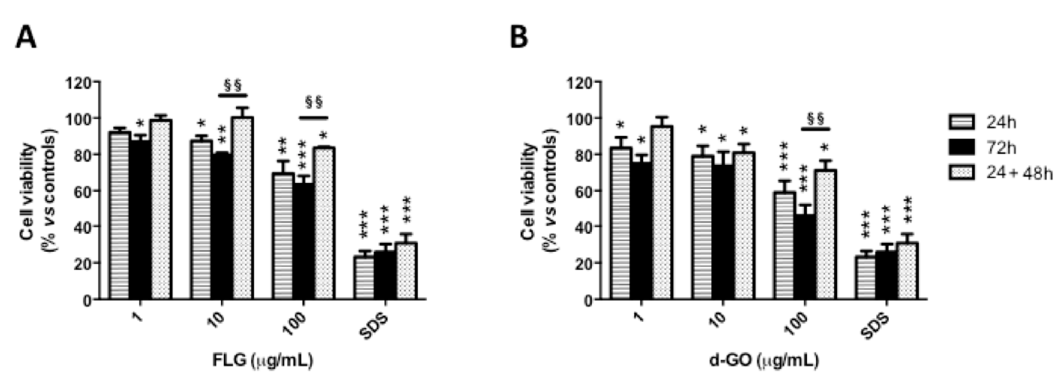
Figure 1. Cytotoxicity of graphene-based materials (GBMs) toward HaCaT cells. HaCaT cells were exposed to GBMs (1, 10 and 100 µ g / mL few layer graphene (FLG; ( A )) or graphene oxide (d-GO; ( B ))) for 24 or 72 h (continuous exposure), or for 24 h followed by 48 h recovery in GBM-free medium (recovery exposure; 24 + 48 h) before the evaluation of cell viability by the WST-8 assay. As a positive control, cells were exposed to 5% sodium dodecyl sulphate SDS. Results are the mean ± standard error (SE) of 3 independent experiments performed in triplicate. Statistical di ff erences vs. negative controls: *, p < 0.05; **, p < 0.01; ***, p < 0.001 (One-way ANOVA and Bonferroni’s post-test). Statistical di ff erences between continuative and recovery conditions: §§ , p < 0.01 (Two-way ANOVA and Bonferroni’s post-test).